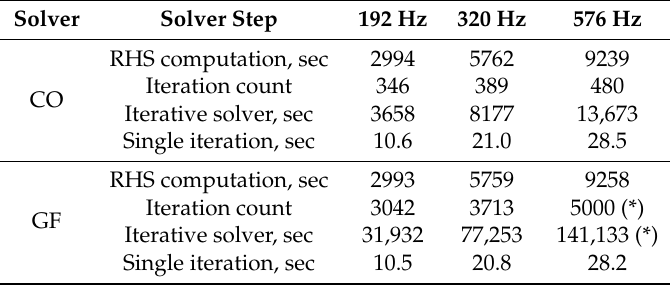
Table 4. Comparison of Green’s function (GF) and contraction operator (CO) preconditioned iterative